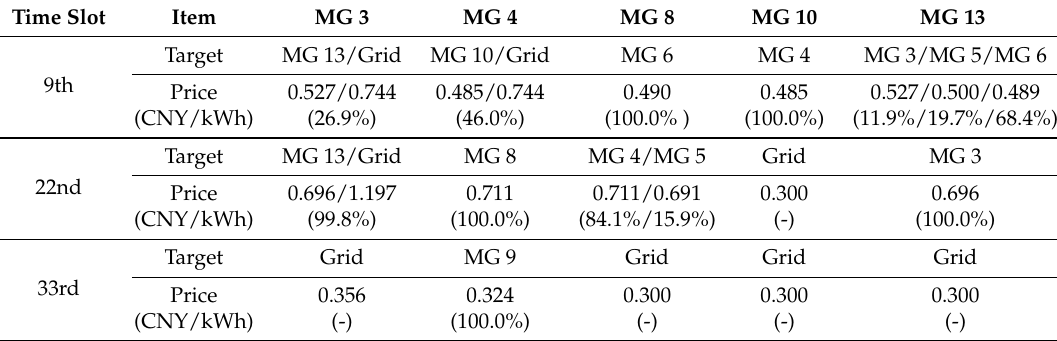
Table 1. Trading target and price of five microgrids in different price